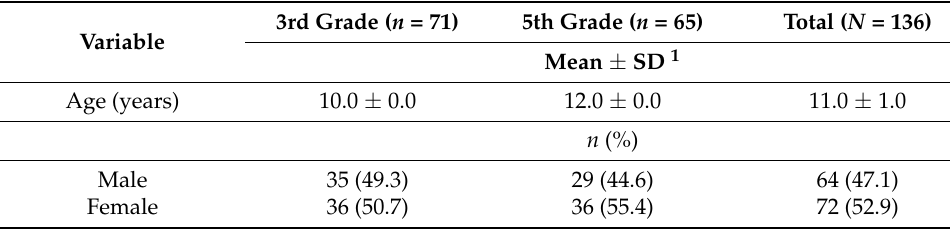
Table 3. Descriptive characteristics of the participating children ( N = 136).